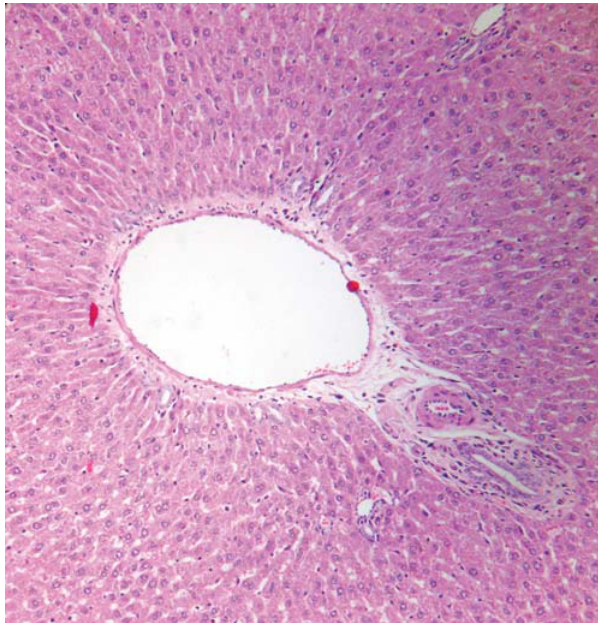
Figure 3 - Normal histological features of the liver in sham-operated rats